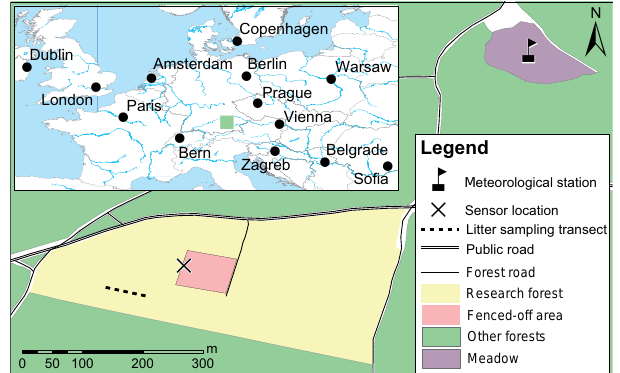
Figure 1. Map of the experimental site, including open-air meteoro- logical station, research forest with fenced-off area, sensor location and litter sampling